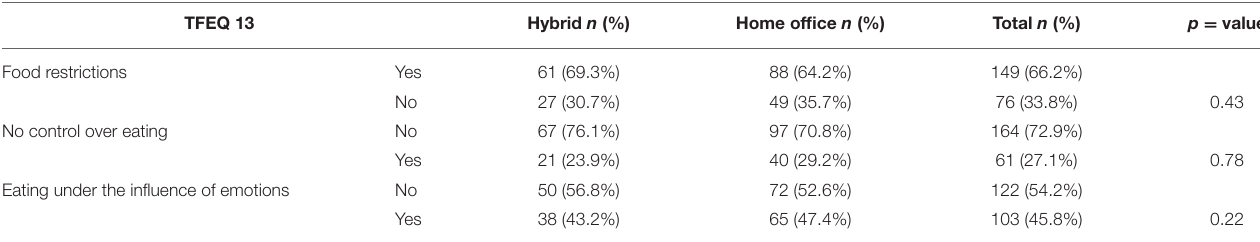
TABLE 4 | Ratings of the emotional aspect of eating behaviors while working remotely during the COVID-19 pandemic ( n = 225). TFEQ